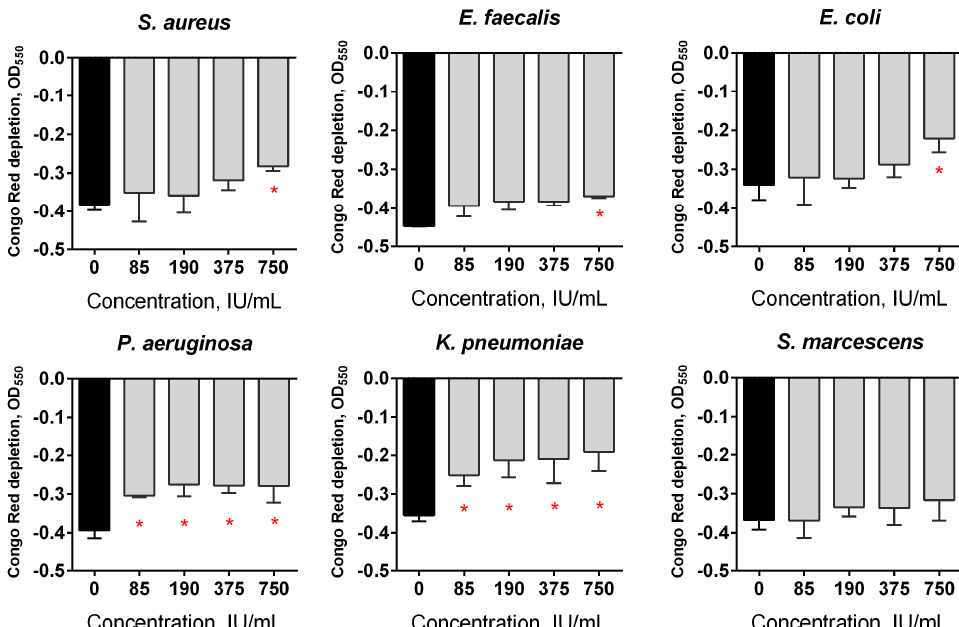
Figure 5. The effect of Longidaza ® treatment on bacterial biofilms. The 48-h old biofilms were gently washed with BM broth, and a fresh BM broth containing Longidaza ® at concentrations of 85–750 IU/mL was loaded. After 24 h of treatment, the residual biofilms were quantified using a Congo Red depletion assay. The asterisks (*) denote a statistically significant difference of the biofilm in the untreated wells and the wells treated with Longidaza ® ( p < 0.05).